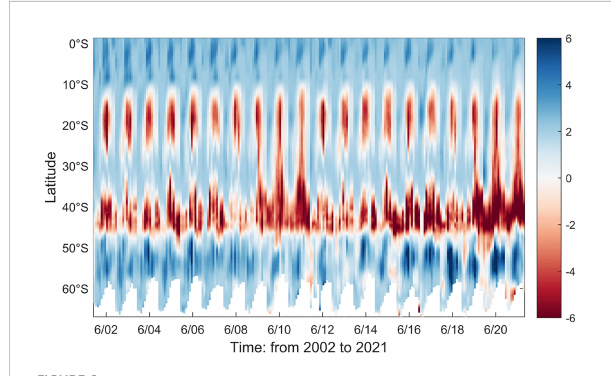
FIGURE 8 Zonal sequence diagram of F (mmol/m 2 ·d) from 2002 to 2021 in the Southern Indian Ocean.